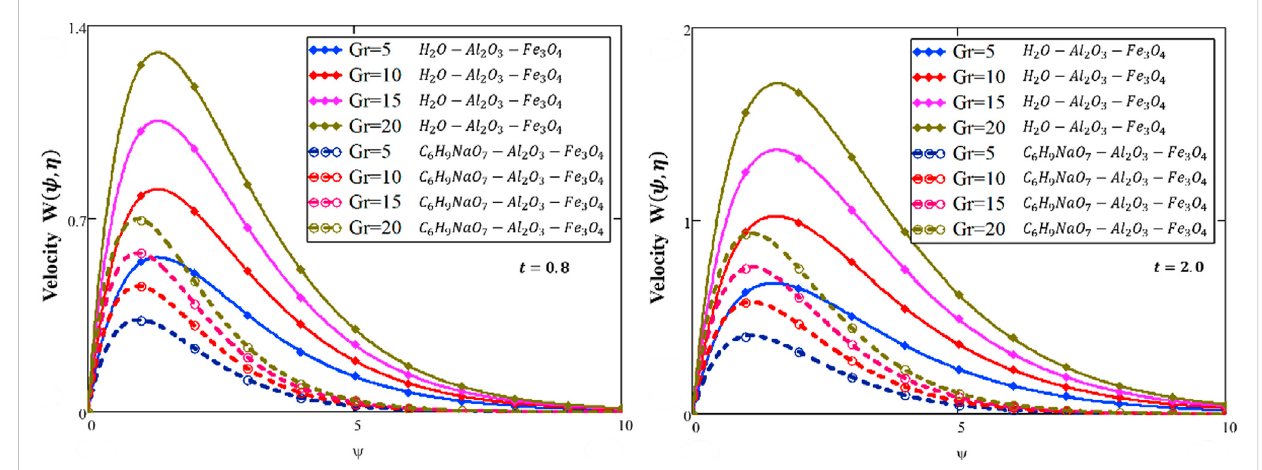
FIGURE 8 Simulation to explain the velocity for changing Gr when α (cid:3) 0 . 4 , Pr (cid:3) 2 . 5 , ϕ 1 (cid:3) ϕ 2 (cid:3) 0 . 2 , Gm (cid:3) 4 . 5 , Sc (cid:3) 0 . 8 , λ 1 (cid:3) 0 . 7 , and λ 1 (cid:3) 0 . 3.